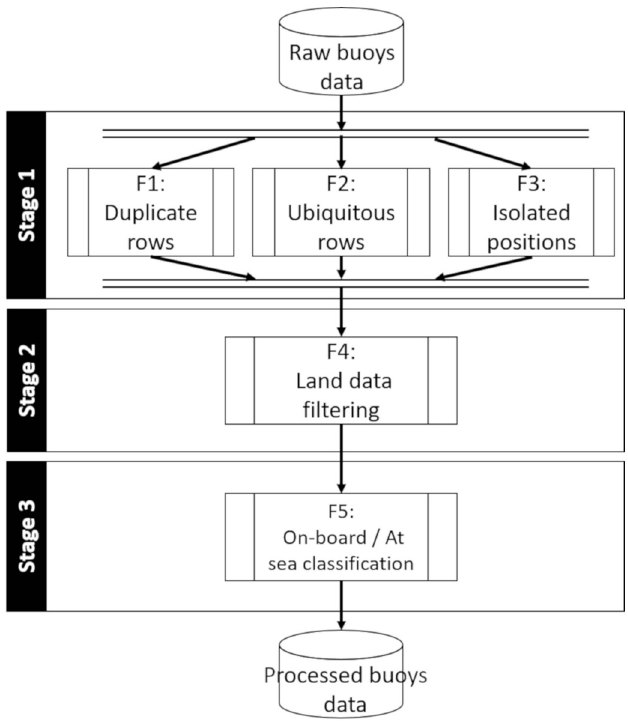
Fig. 3. Flowchart of the standard processing protocol for satellite- linked echosounder buoys used in tropical tuna purse seine fi